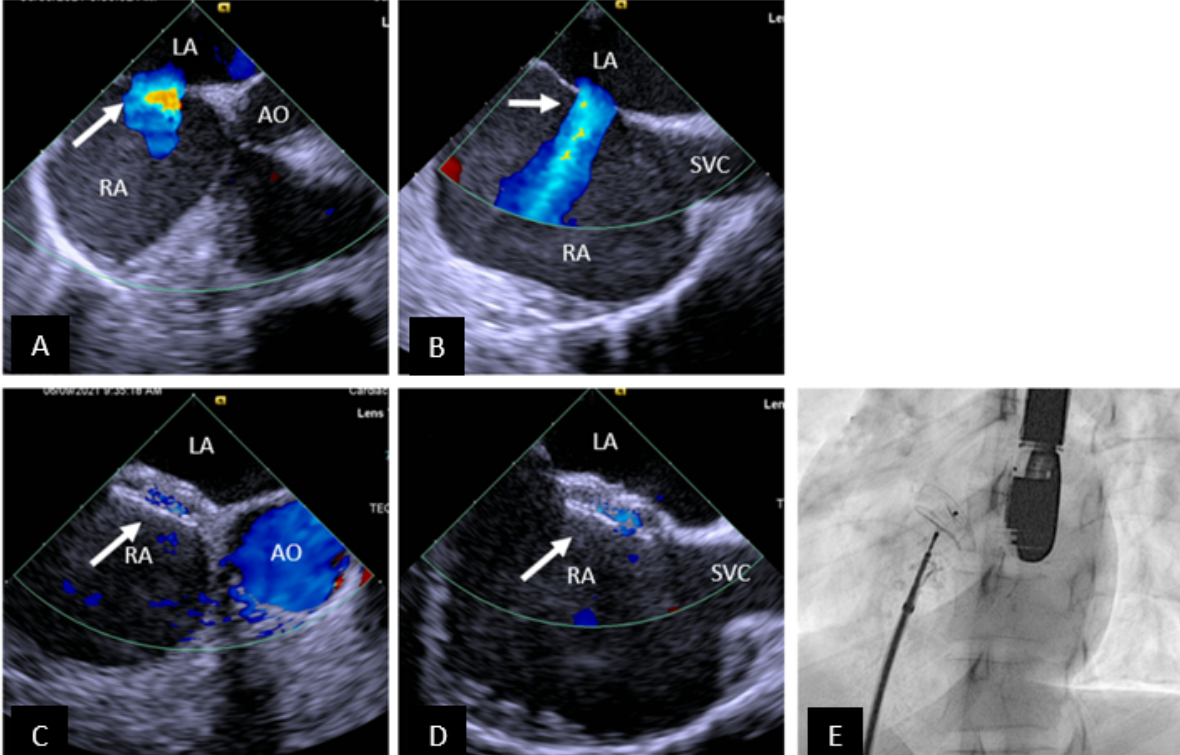
Figure 1. Transcatheter ASD closure with Amplatzer Septal Occluder. ( A ) 45° TEE view showing central secundum ASD (arrow) with good sized aortic rim. ( B ) 90° TEE view showing ASD (arrow) with good SVC rim. ( C , D ) Well positioned ASD device (arrow) in same views as ( A , B ) respectively. There is no residual shunting. ( E ) Fluoroscopic left anterior oblique view showing device position prior to release. SVC = superior vena cava, AO = aorta, RA = right atrium, LA = left atrium.